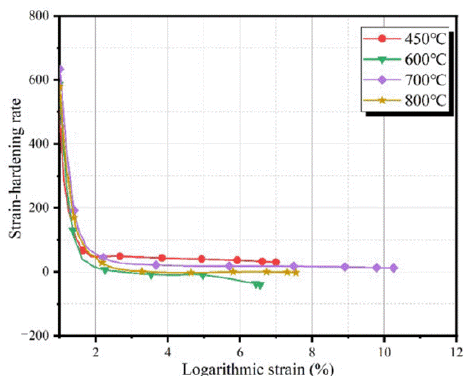
Figure 10. The compressive strain-hardening rate ( Θ = d σ /d ε ) vs. the logarithmic strain of the studied alloys.